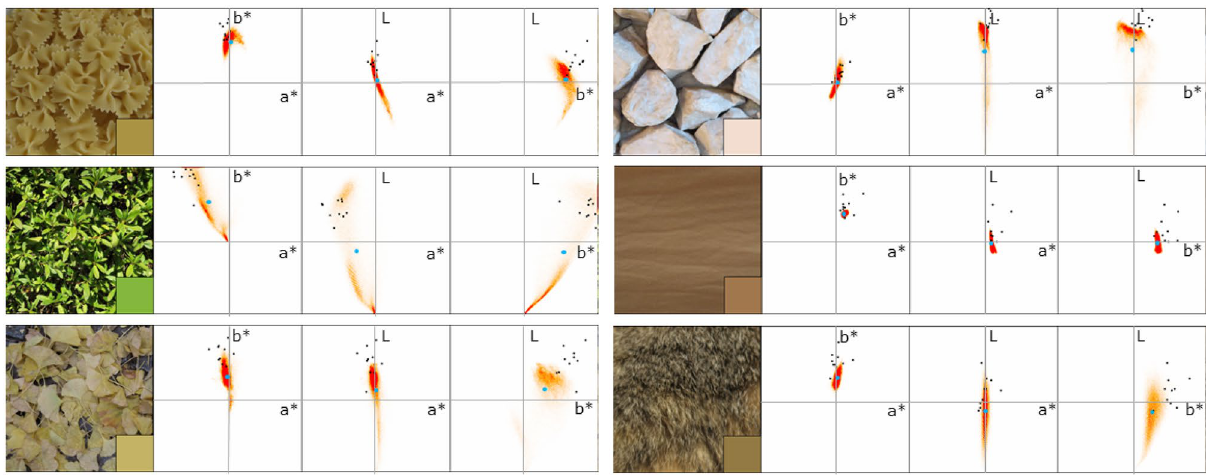
Figure 3. Examples of representative colors matched for natural surfaces. The test image is on the left of each panel. The lower right inset patch shows the matched lightness and color averaged across observers. The three scatter plots on the right represent the joint histogram of the test stimulus pixels plotted on the a * vs. b * , L vs. a * , and L vs. b * planes (red clouds), the between-observer average of the matched representative color (black dots), and the pixel mean of the test image (blue dots), respectively. Error bars represent the s.e.m. among 10